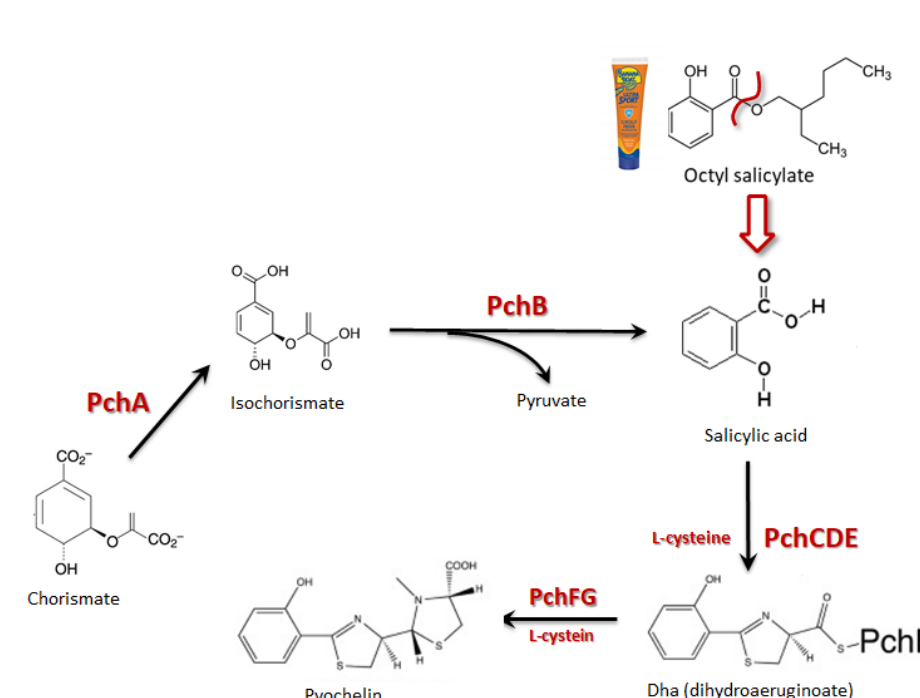
Figure 1. Chorismate cycle in Pseudomonas aeruginosa and Burkholderia cepacia incorporated with the hypothesized hydrolysis of octyl salicylate ultraviolet (UV)-filter from sunscreen formulations to salicylic acid, a precursor for pyochelin biosynthesis.